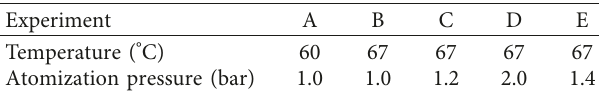
Table 5: Experiments and their process conditions.